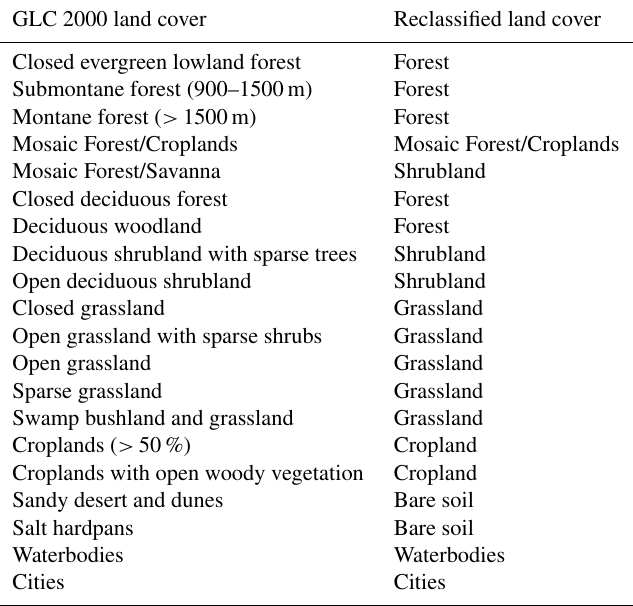
Table A1. GLC 2000 reclassification.